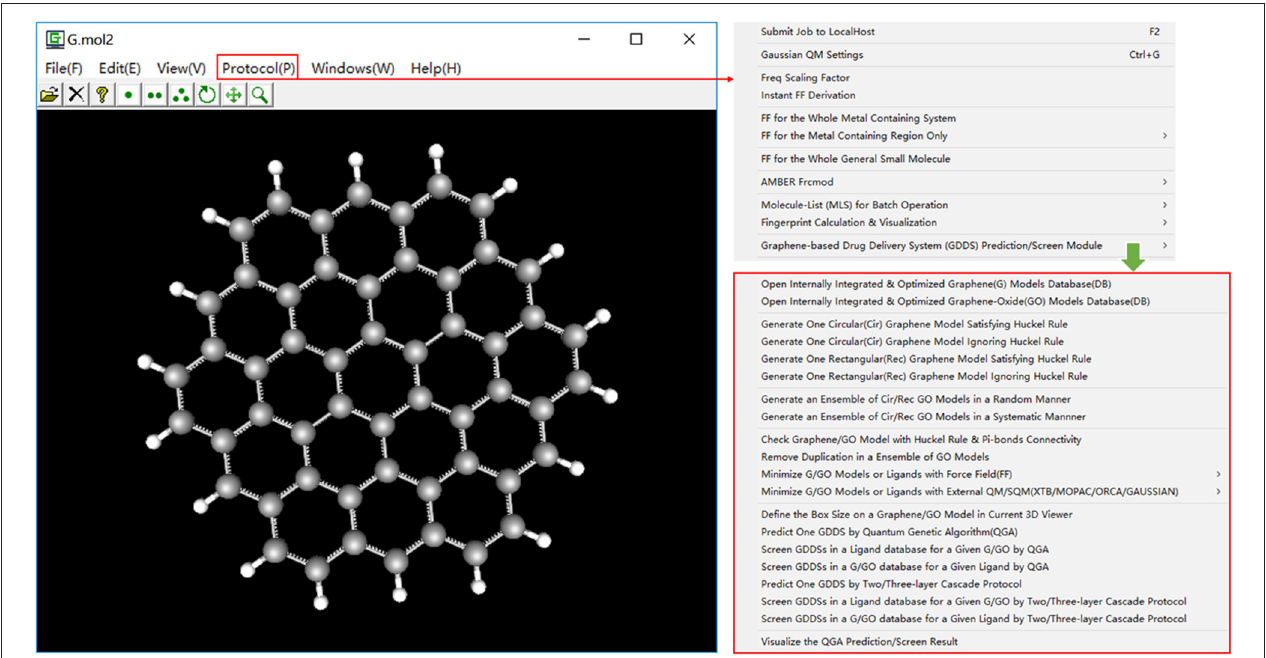
FIGURE 1 | The main interface of e-Graphene program for the automatic prediction/screen of graphene-based drug delivery system (GDDS) by quantum genetic algorithm (QGA) and cascade protocol.